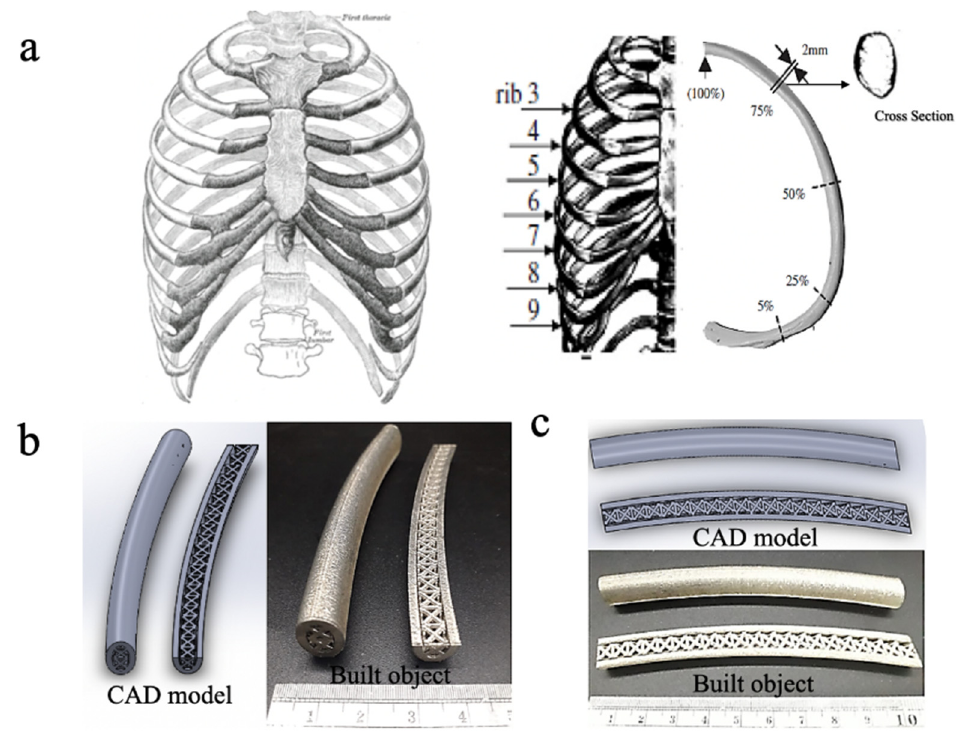
Figure 16. Rib implant images from ( a ) human rib configuration, ( b ) side view and top view ( c ) of CAD model and built object.